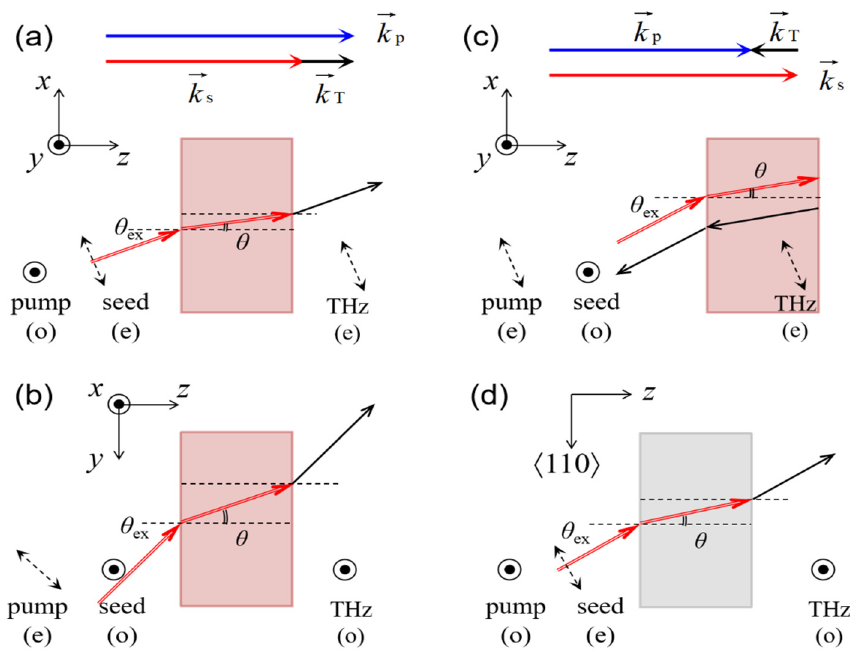
Figure 2. Schematic diagram of birefringent PM configurations: ( a ) oee-type, ( b ) eoo-type, ( c ) backward in GaSe, and ( d ) oeo-type in ZnGeP 2 .